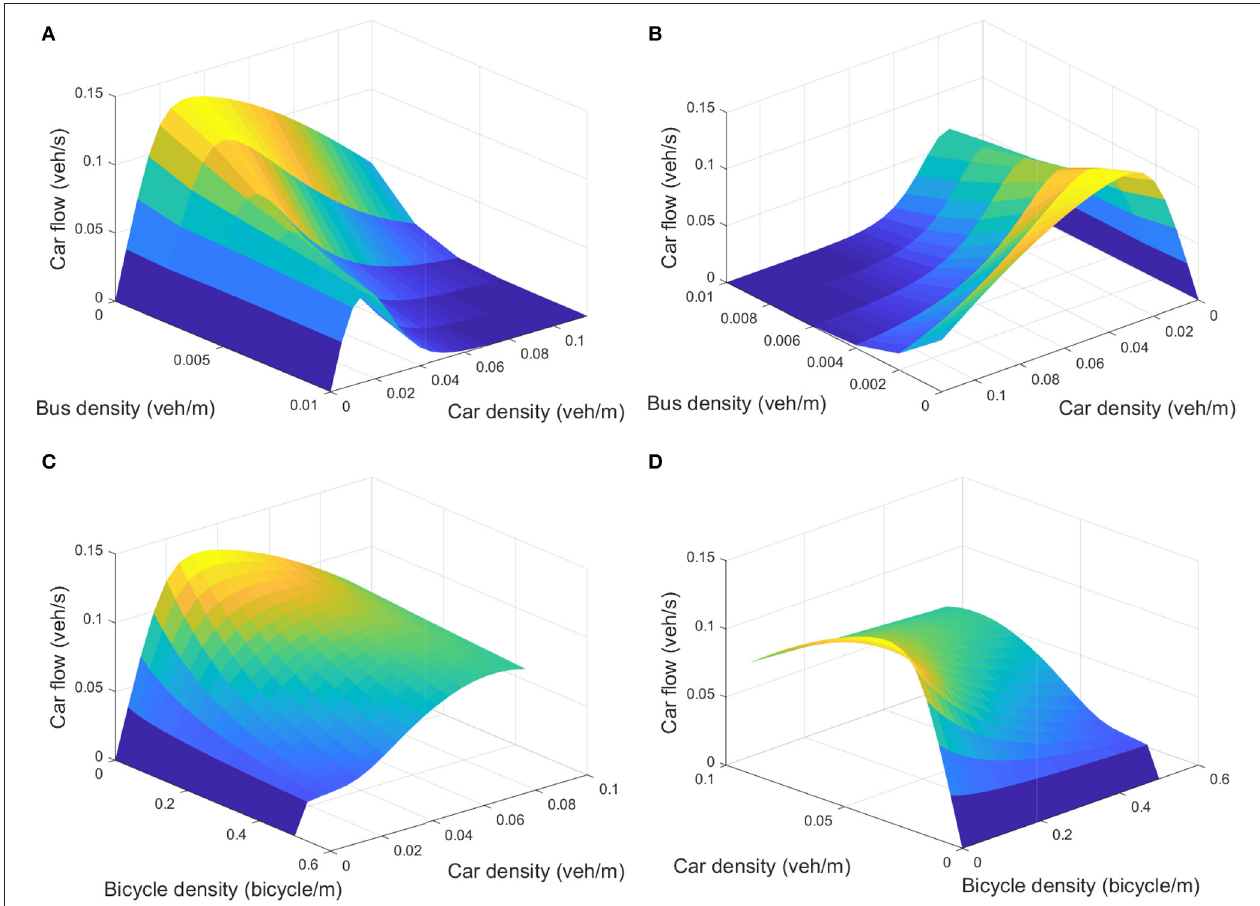
FIGURE 3 | Car MFDs with interaction effects. (A,B) Show the bi-modal interaction effects between buses and cars on car flow; (C,D) show the bi-modal interaction effects between bicycles and cars on car flow. Each bi-modal pair of figures is numerically identical, but the perspective differs. All MFDs are based on the parameters listed in Appendix Table 2